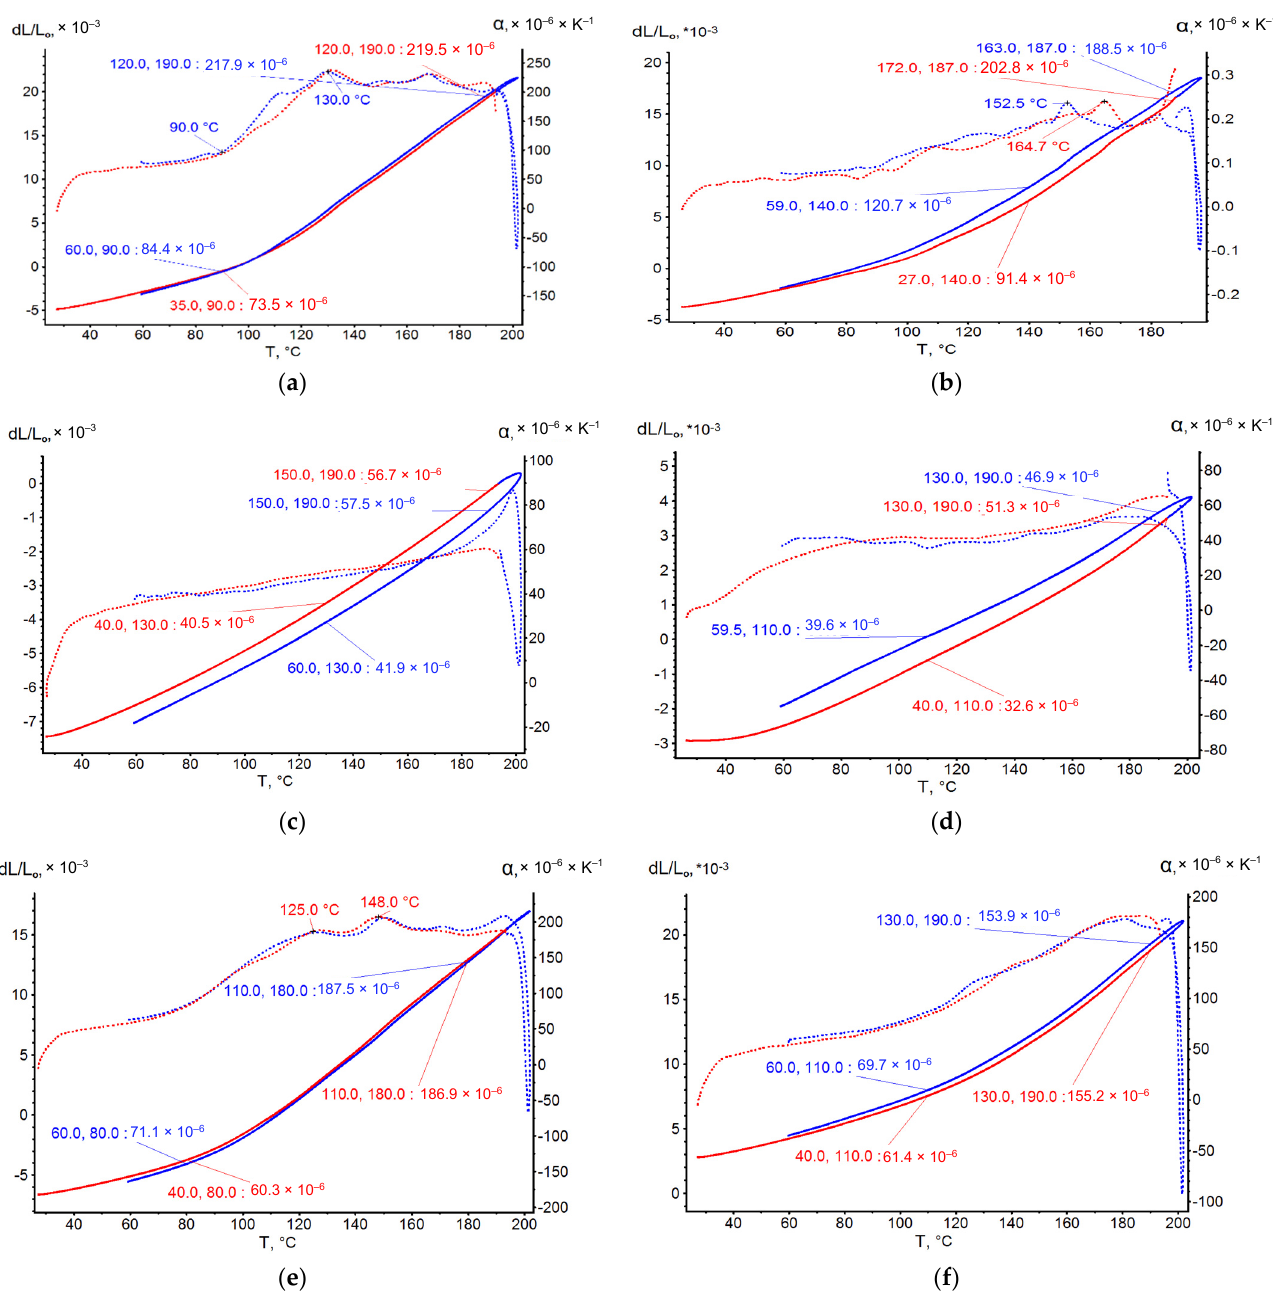
Figure 6. Thermal expanding curves: ( a ) EP, ( b ) EP after T–relax, ( c ) PF, ( d ) PF after T–relax, ( e ) EP–PF, ( f ) EP-PF after T-relax.